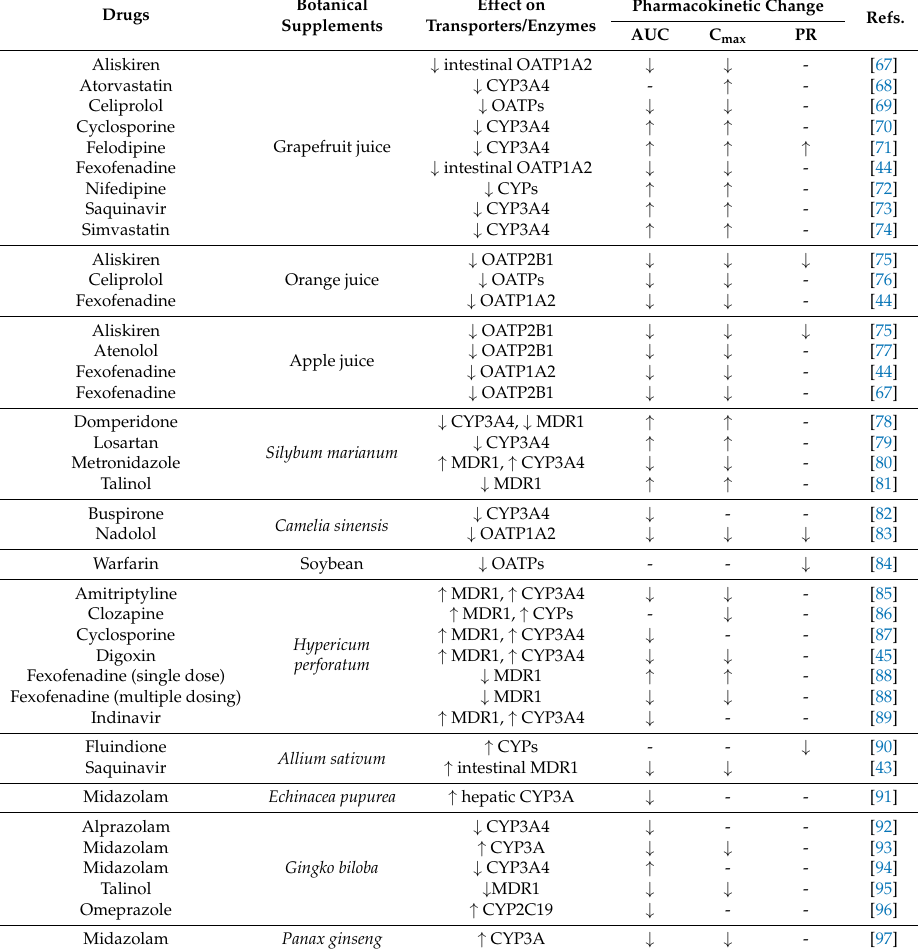
Table 2. Reported interactions between the clinically prescribed drugs and botanical